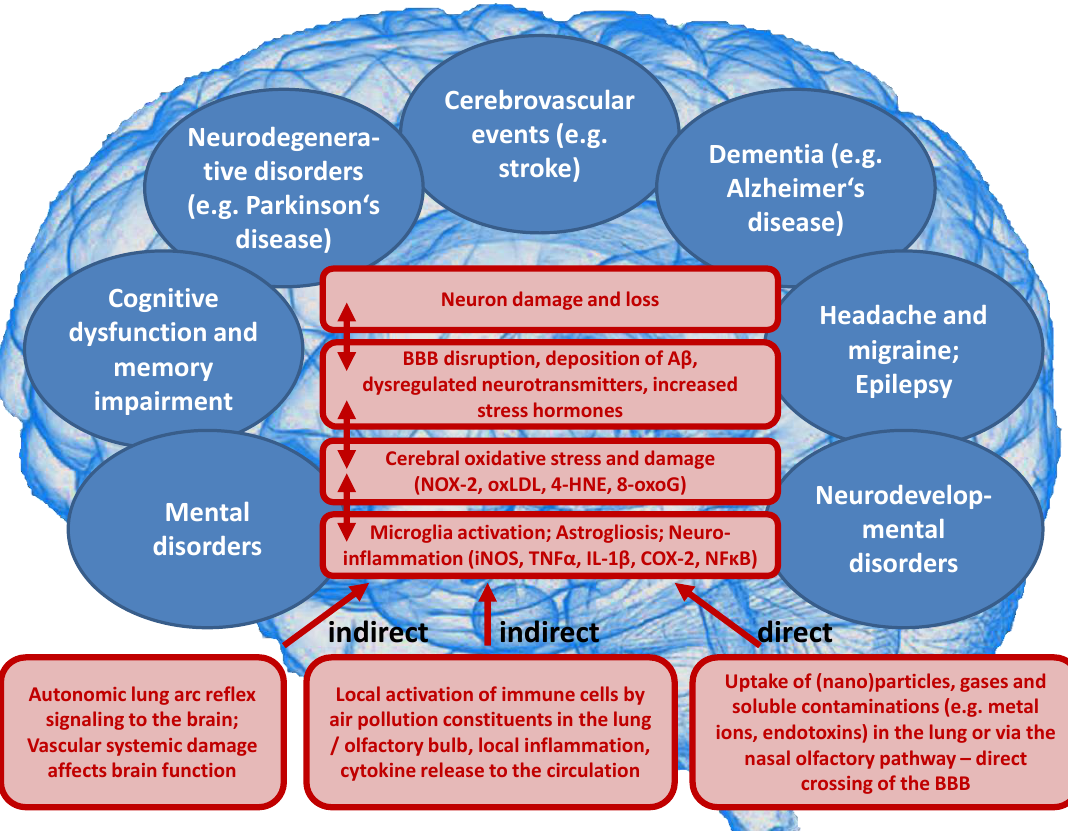
Figure 5. Proposed concept how air pollution constituents contribute to neurological and mental disorders. Uptake of fine particulate matter, reactive gases or secondary environmental toxins (bound to the solid or liquid aerosol particles) such as heavy metals, endotoxins or photoreaction / atmospheric chemistry products (e.g., reactive aldehydes, nitrated VOCs) by three major pathways (indirect or direct). Neuroinflammation and cerebral oxidative stress by microglia activation impairs vital pathways in the brain initiating pathophysiological processes such as amyloid deposition and neuron damage and loss. BBB, blood-brain barrier; iNOS, inducible nitric oxide synthase; TNF α , tumor necrosis factor alpha; IL-1 β , interleukin 1beta; COX-2, (inducible) cyclooxygenase 2; NF κ B, nuclear factor ‘kappa-light- chain-enhancer’ of activated B-cells; NOX-2, NADPH oxidase isoform 2 (phagocytic NADPH oxidase); oxLDL, oxidized low density lipoprotein; 4-HNE, 4-hydroxynonenal;